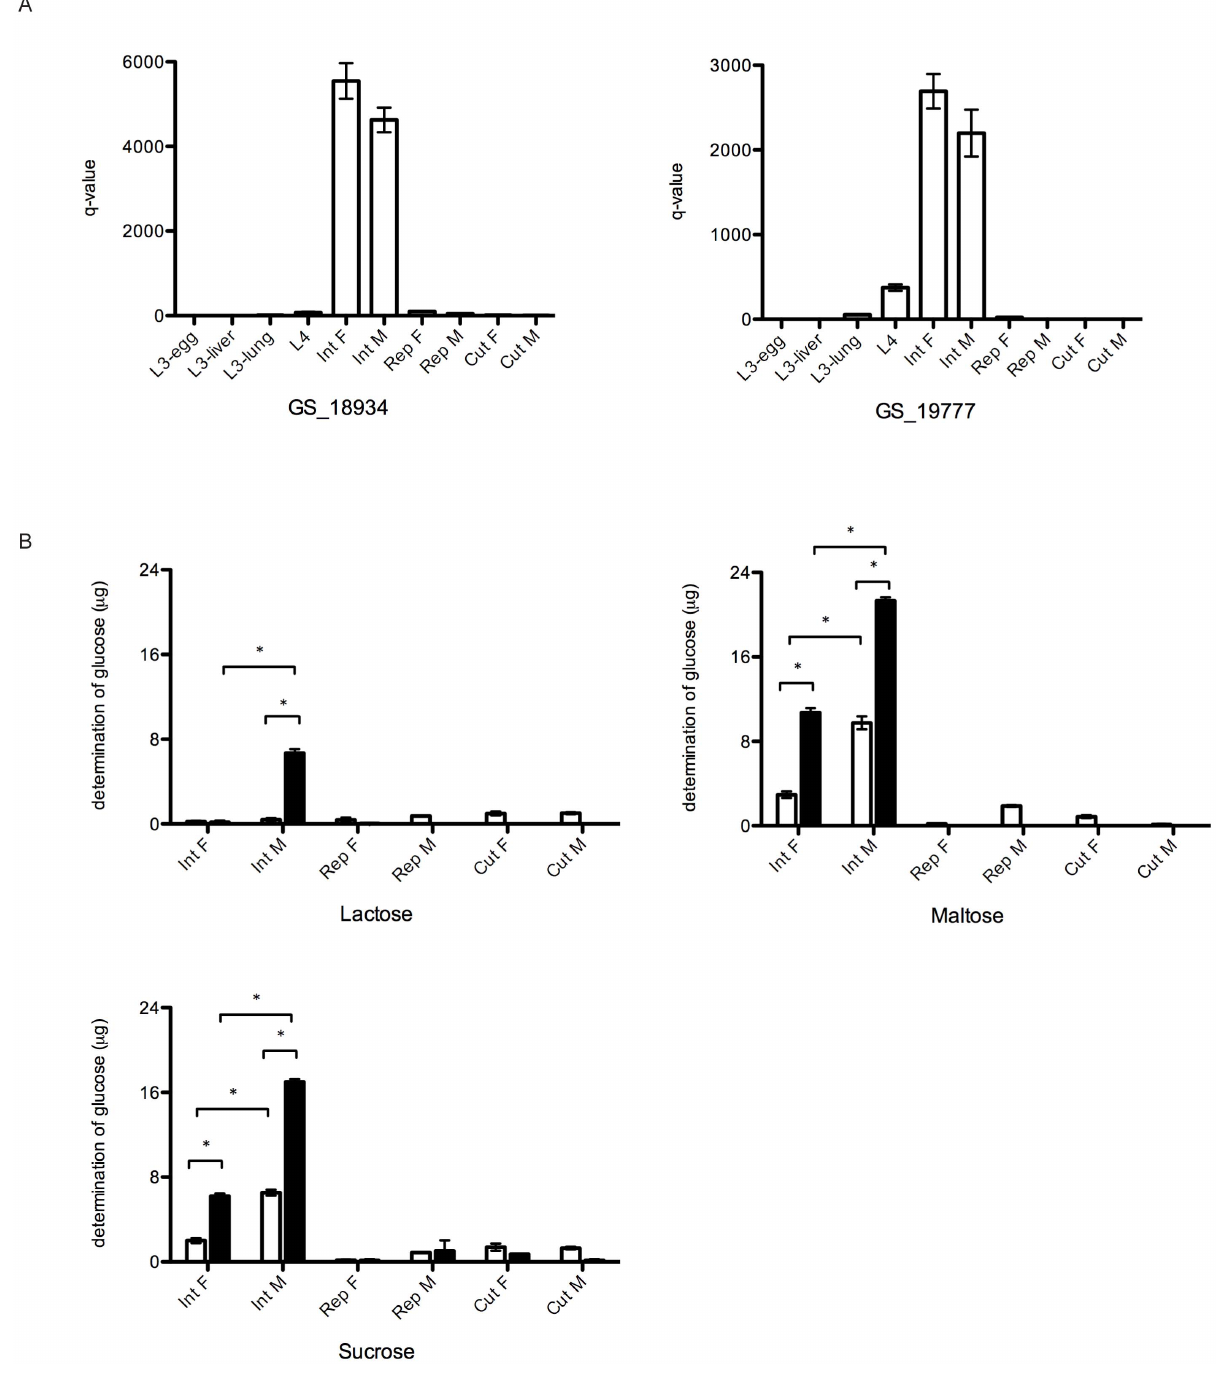
Figure 5. qPCR and glucosidase hydrolytic activity analysis of GH31 proteins. A. A qPCR analysis for two GH31 proteins on cDNA produced from different larval stages and adult worm tissues. B. Comparison of the glucosidase hydrolytic activity in water-soluble (white bars) and water- insoluble extract (black bars) from different adult tissues. Results are shown as average + SD. Substrates used in the assays were lactose, maltose and sucrose. (Int F: female intestine; Int M: male intestine; Rep F: female reproductive system; Rep M: male reproductive system; Cut F: female cuticle; Cut M: male cuticle). (* P , 0.05).